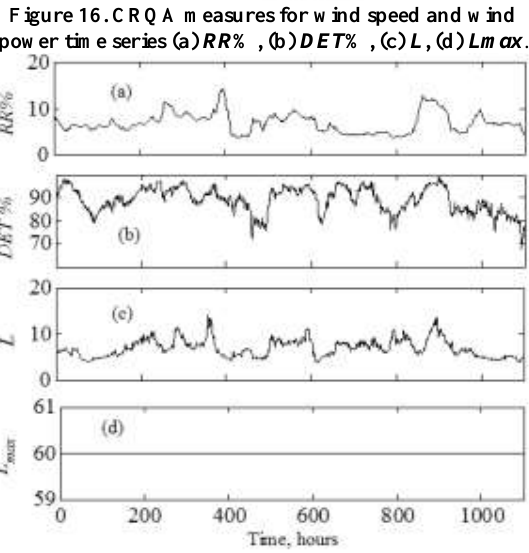
Figure 17. JRQA measures for wind speed and